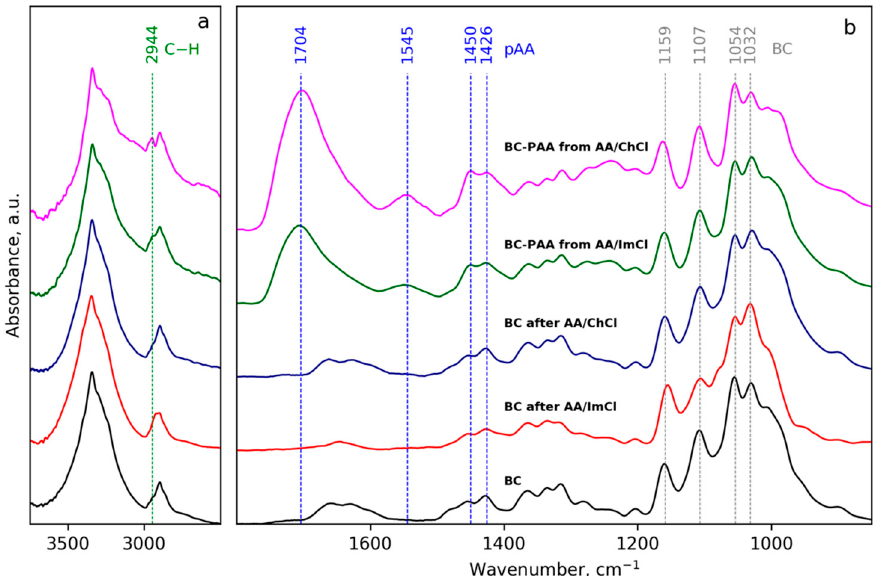
Figure 7. FTIR spectra of initial BC, BC after AA/ImCl and after AA/ChCl, BC-poly(acrylic acid) (BC-PAA) from AA/ImCl and from AA/ChCl in the regions 3700–2500 cm − 1 ( a ) and 1800–900 cm − 1 ( b ).